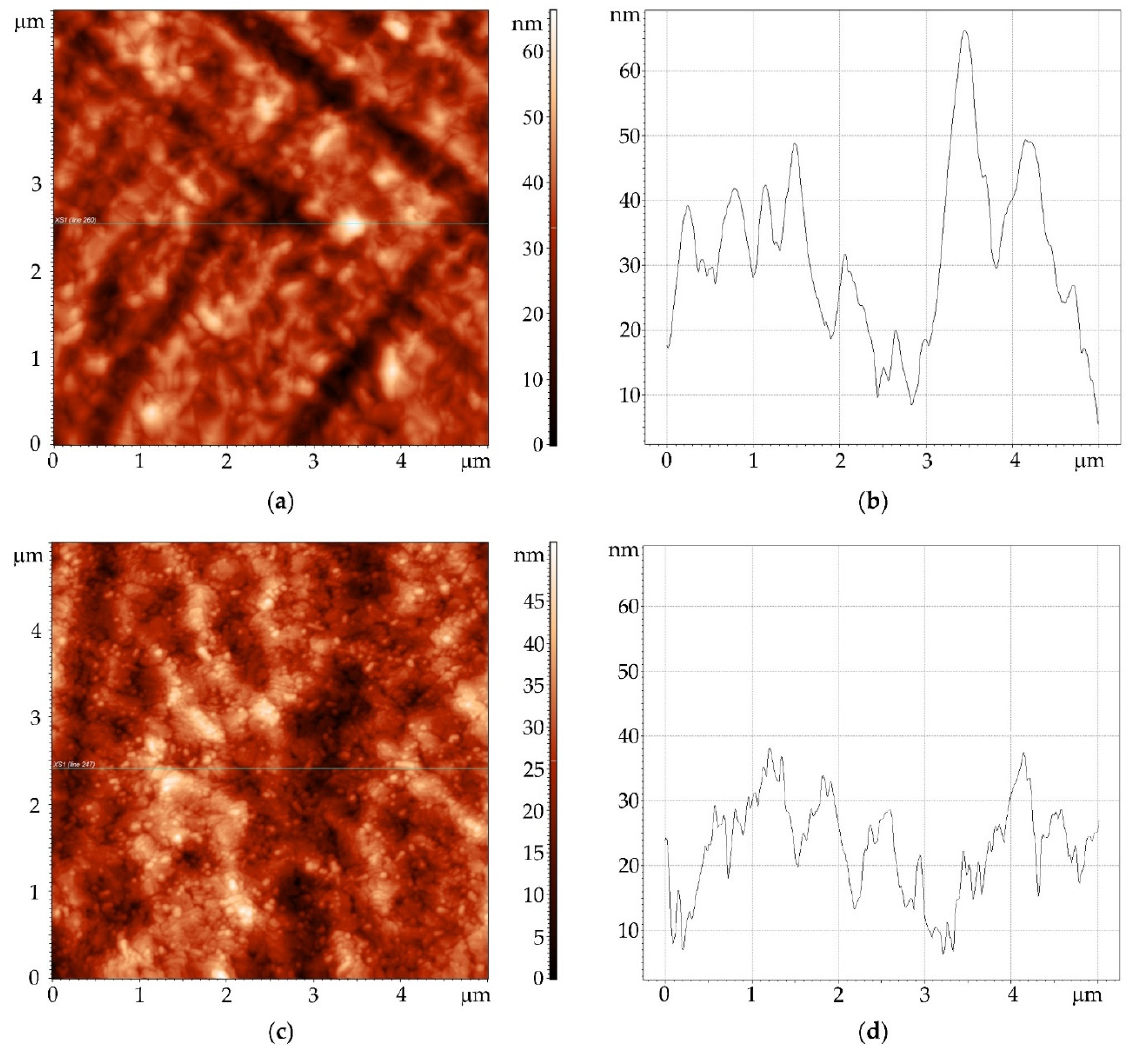
Figure 4. ACM images of BTS films on alumina before ( a , b ) and after ( c , d ) annealing. Planar capacitors are formed on the basis of BTS films deposited in a gas medium Ar(80%)/O 2 (20%) at different substrate temperatures. The dependences of the capacitance normalized by the maximum value of the capacitors under study on the strength of the control electric field are shown in Figure 5. It follows from the figure that the capacitor based on the non-annealed film exhibits minimal tunability, which is explained by the composition of the solid solution BaTi 0.4 Sn 0.6 O 3 , most of which is a linear dielectric BaSnO 3 . The tunability of capacitors formed on the basis of annealed films of BaTi 0.8 Sn 0.2 O 3 composition depends on film thickness. For films of 400 nm thickness, it increases from 2.8 to 3.4 with an increase in the deposition temperature from 650 to 850 ◦ C. The tunability of capacitor based on 800 nm film is 6.8 times (85%), which is the best result for BTS capacitors today. For a capacitor with a planar structure, the total capacitance is composed of three components: air, BTS film and substrate. In this configuration, tunability only comes from BTS film since the substrate shows no tunability, being the linear dielectric. Then the thickness of the FE film will affect the tunability, because in the case of a thin FE film, some part of the field will penetrate into the substrate with a low dielectric